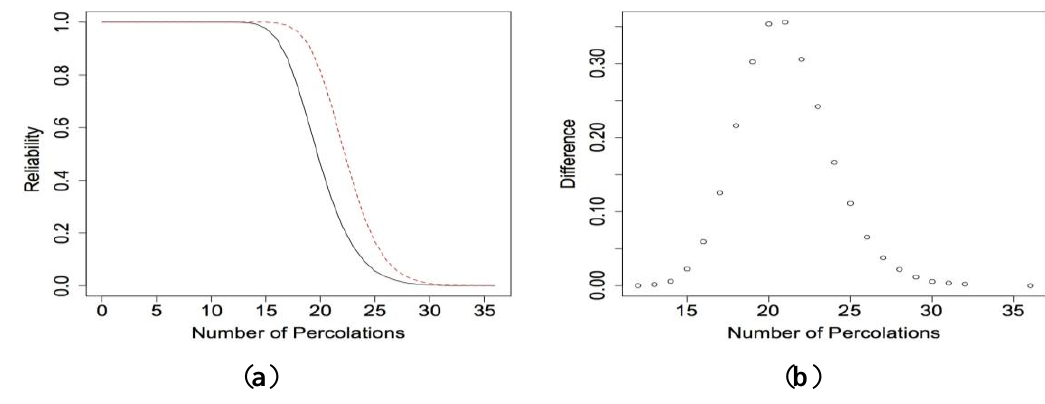
Figure 11. ( a ) R E ( x ) calculated using our algorithm when the electrical current can 21 × 21 move in all directions (top curve) and when movement is restricted (bottom curve) when p = 0.95 and ( b ) the difference between the R E ( x ). 21 × 21